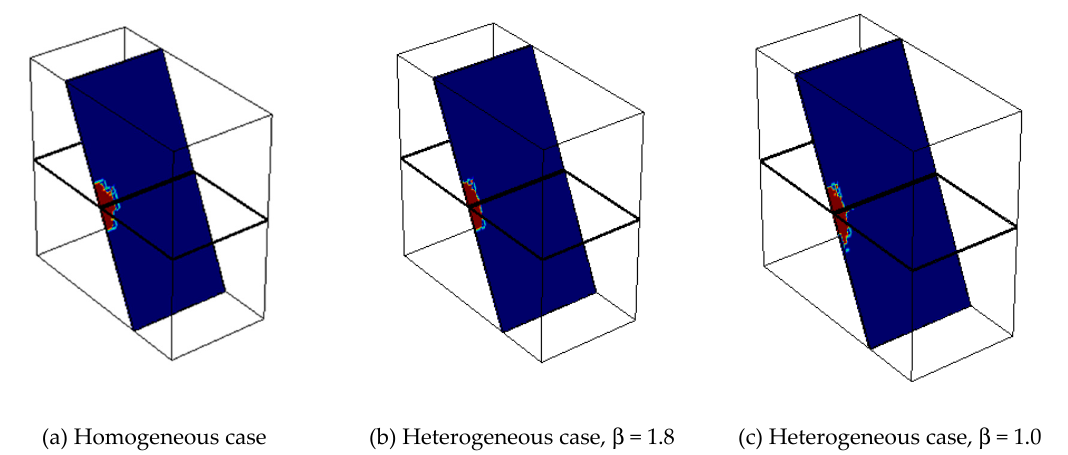
Figure 13. Extent of fault failure; comparison between homogeneous and heterogeneous case. The red colour shows the failure zone in the fault.